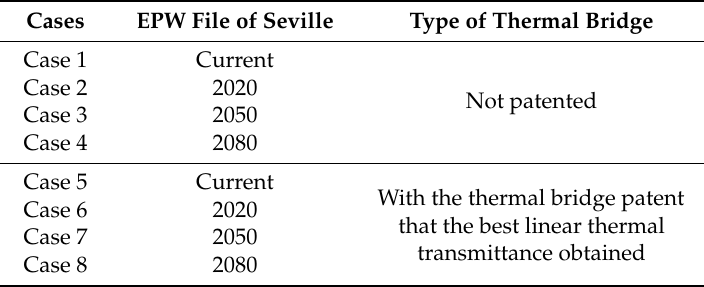
Table 3. Configuration of the energy simulation cases analysed.